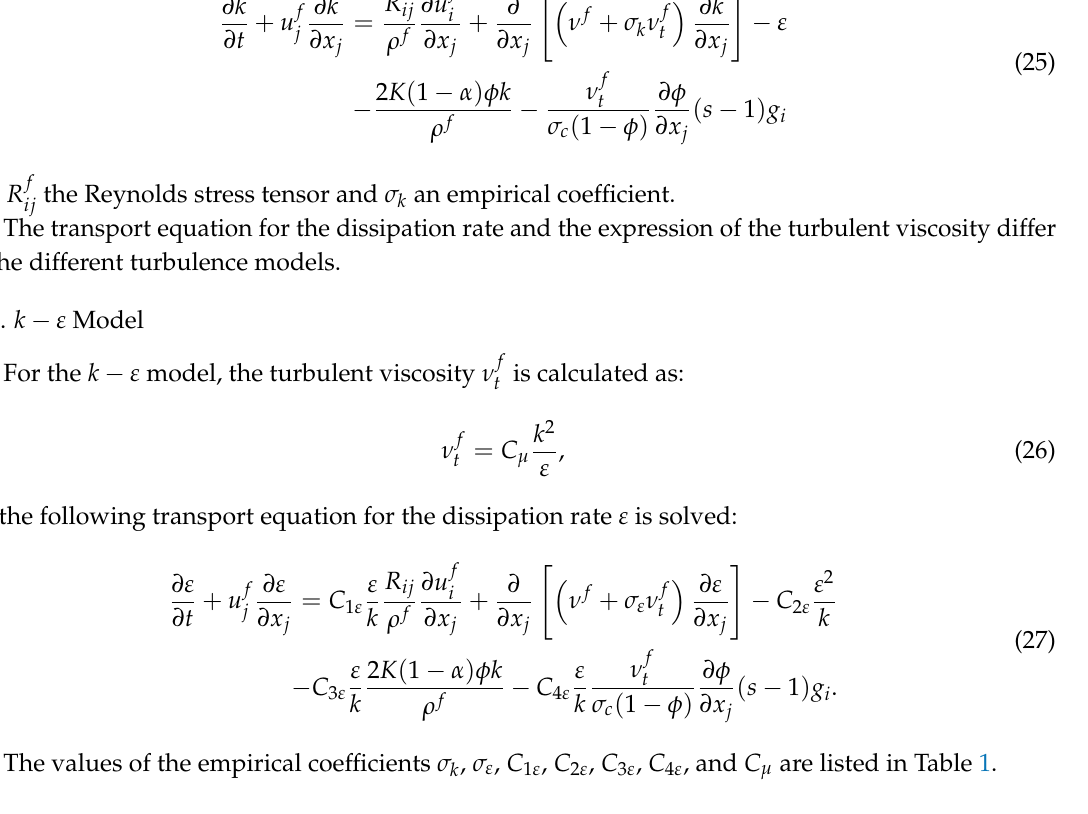
Table 1. Empirical coefficients for the k − ε turbulence model from Chauchat et al. (2017) [17]. σ k σ ε C 1